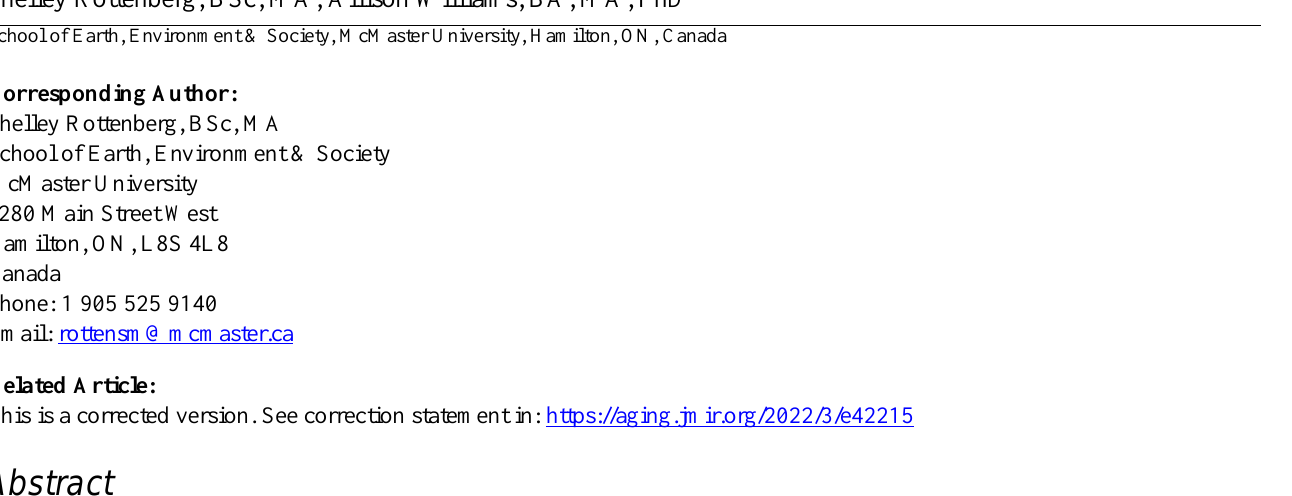
informal caregivers; family caregivers; older adults; elder care; web-based intervention; online intervention; online course; health education; eHealth;